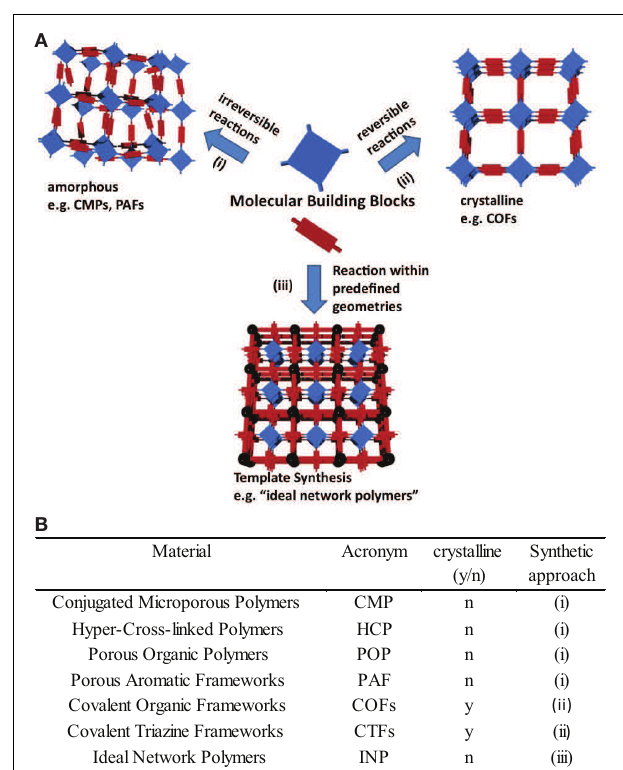
FIGURE 2 | (A) Synthesis approaches to create organic polymer networks via (i) intrinsic porosity of rigid building blocks, (ii) self-assembly of